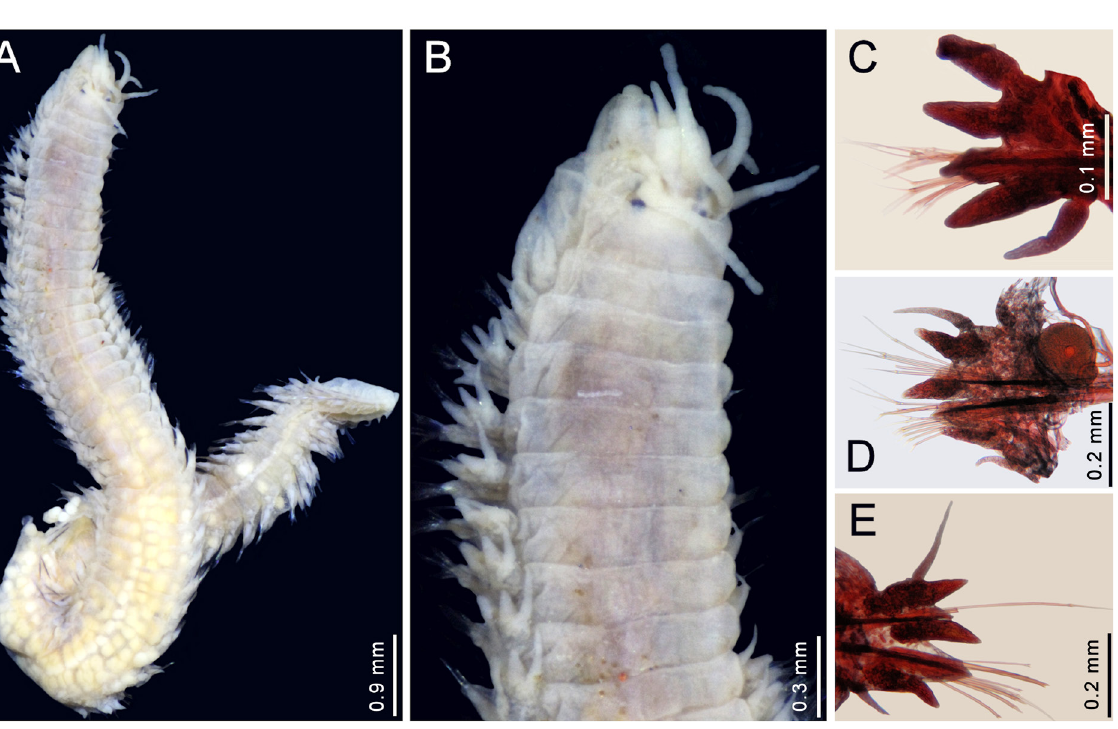
Fig. 20. Nereis mezianei sp. nov., mature female (MNHN 372-T28). A . Dorsal view. B . Anterior region, dorsal view. Parapodia stained with Shirslastain-A. C . Chaetiger 2, right parapodium, anterior view (dorsal cirrus bent). D . Chaetiger 35, left parapodium, posterior view. E . Chaetiger 52, right parapodium, posterior